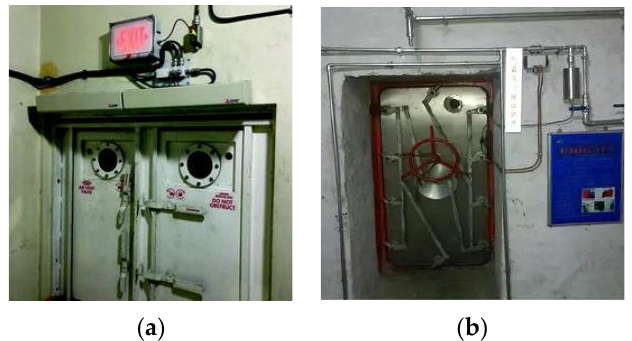
Figure 1. Diagram of the structure and installation position of the mine refuge air curtain [31]. ( a ) Air knife air curtain installed on top side. ( b ) Pipeline air curtain installed on three sides.